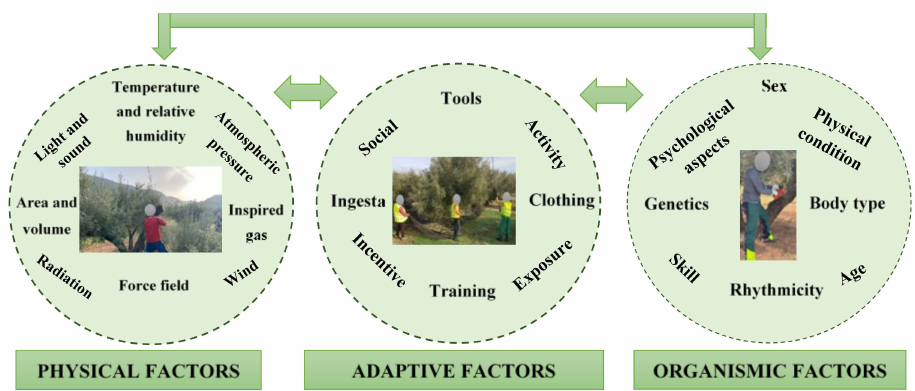
Figure 4. Relationship between physical, adaptive and organismic factors. Adapted from